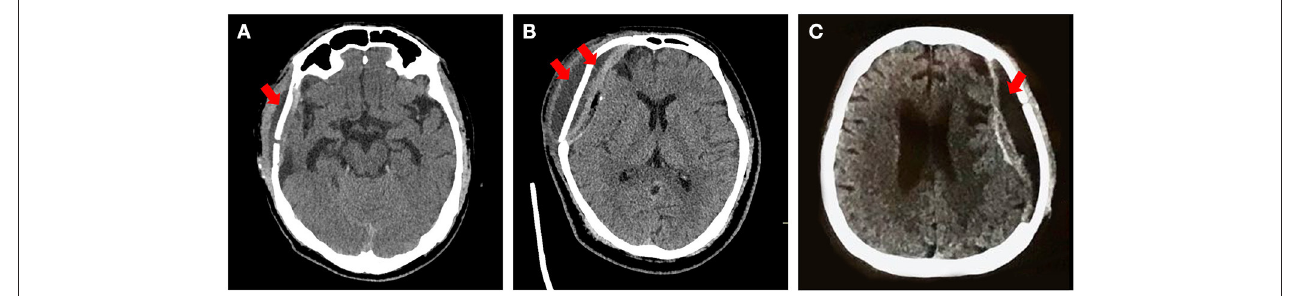
FIGURE 2 | Typical types of effusion after PEEK cranioplasty. Red arrow: the effusion presents as a low-density area under the scalp on CT. (A) Subcutaneous effusion mainly outside the plate. (B) Subcutaneous effusion complicated with epidural effusion. (C) Effusion only at the epidural space.